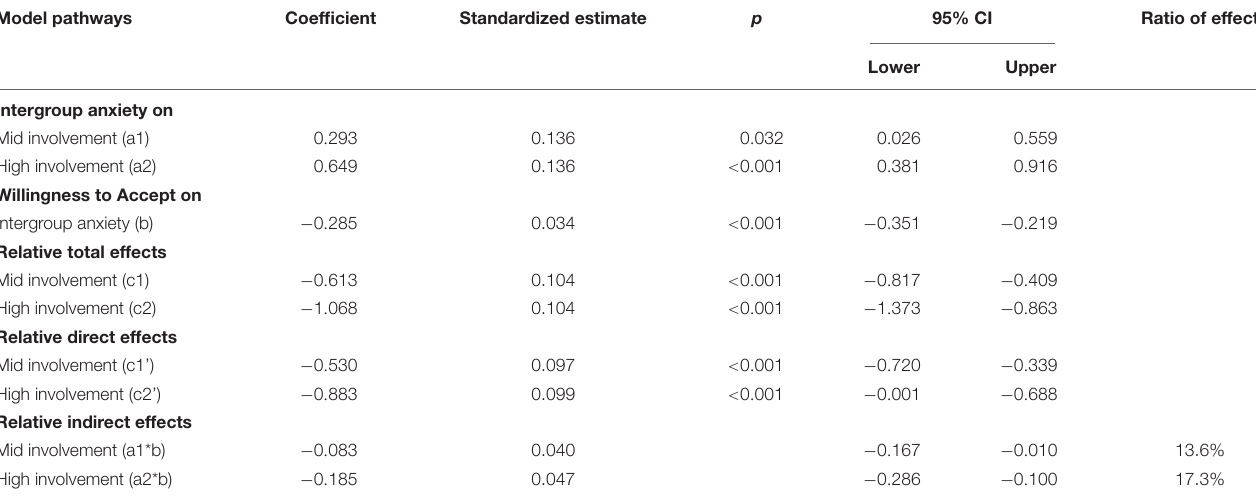
TABLE 3 | The mediating role of intergroup anxiety ( n = 330). Model pathways